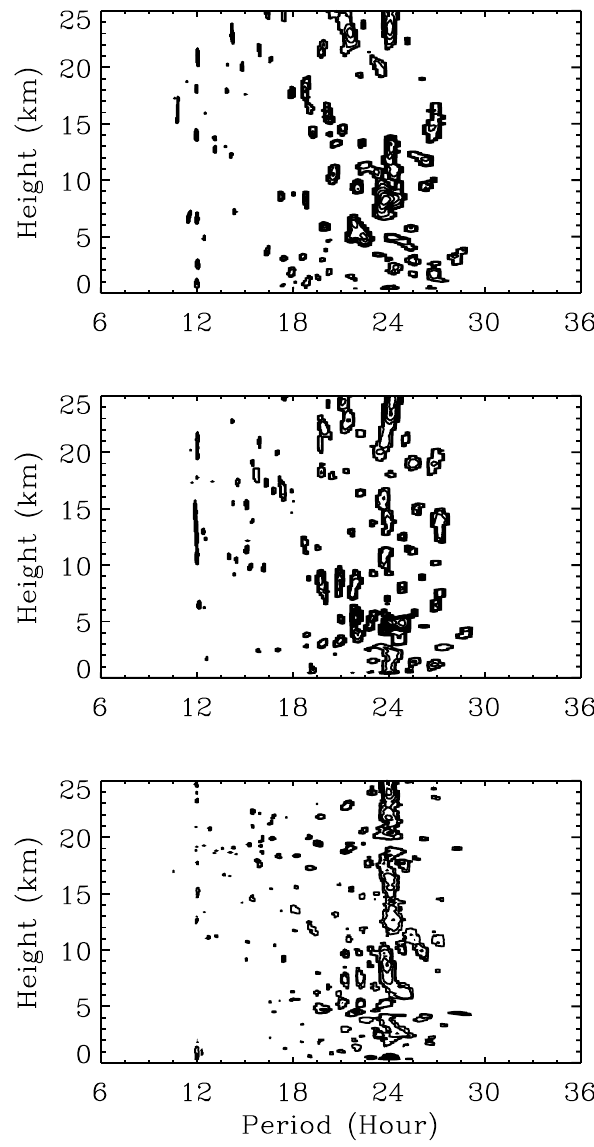
Fig. 5. Similar to Fig. 4, but in January 2007. The minimum values and the intervals of the contours for the zonal and meridional winds are all 0.25ms − 1 , and for the temperature are all